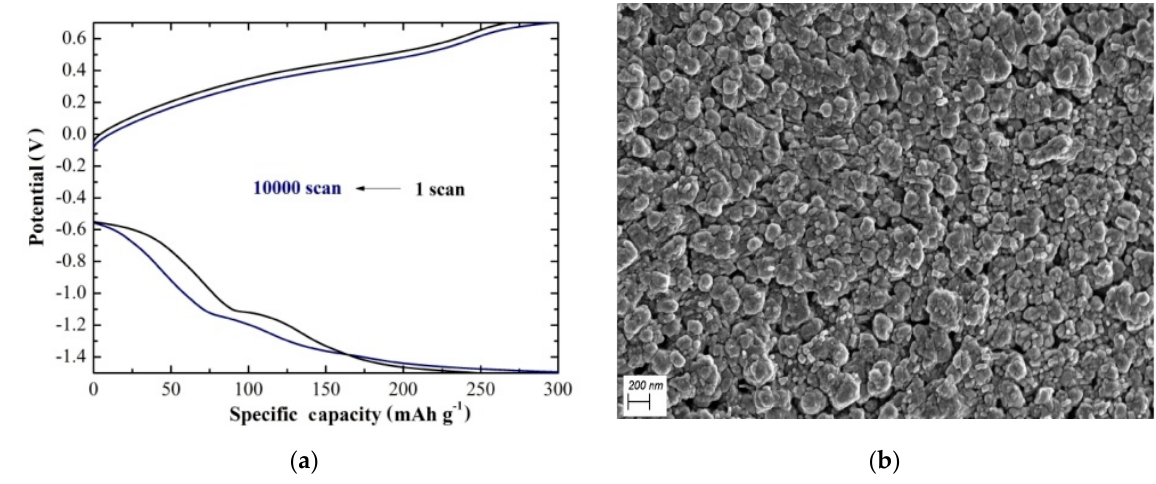
Figure 1. ( a ) Specific capacity for the AACVD V 2 O 5 at 600 °C at a potential ranging from − 1.5 V to +0.7 V under constant specific current of 15 A g − 1 for 1 and 10,000 scans. ( b ) FE-SEM image of the same material at ×100,000 magnification.